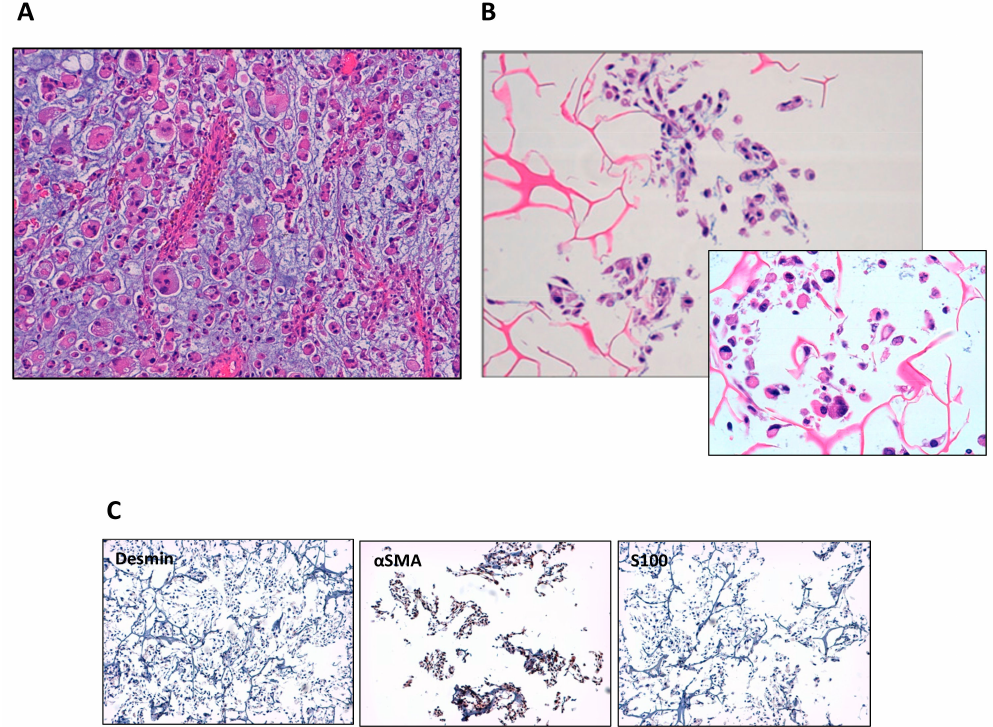
Figure 1. Morphologic comparison between the patient’s tumor tissue and primary culture. H&E staining of the patient’s tumor tissue. The image shows high-grade myxofibrosarcoma cells and the myxoid matrix (light-blue stroma) at 20 × magnification ( A ). H&E staining of the patient-derived primary culture. Some of the morphologic features of the tissue of origin are maintained, i.e., the presence of giant cells, prominent nuclei and disseminated vacuoles at 20 × and 40 × magnification ( B ). Immunohistochemical staining for desmin, α SMA and S100 on IM-MFS-1 at passage 1 at 20 × magnification ( C